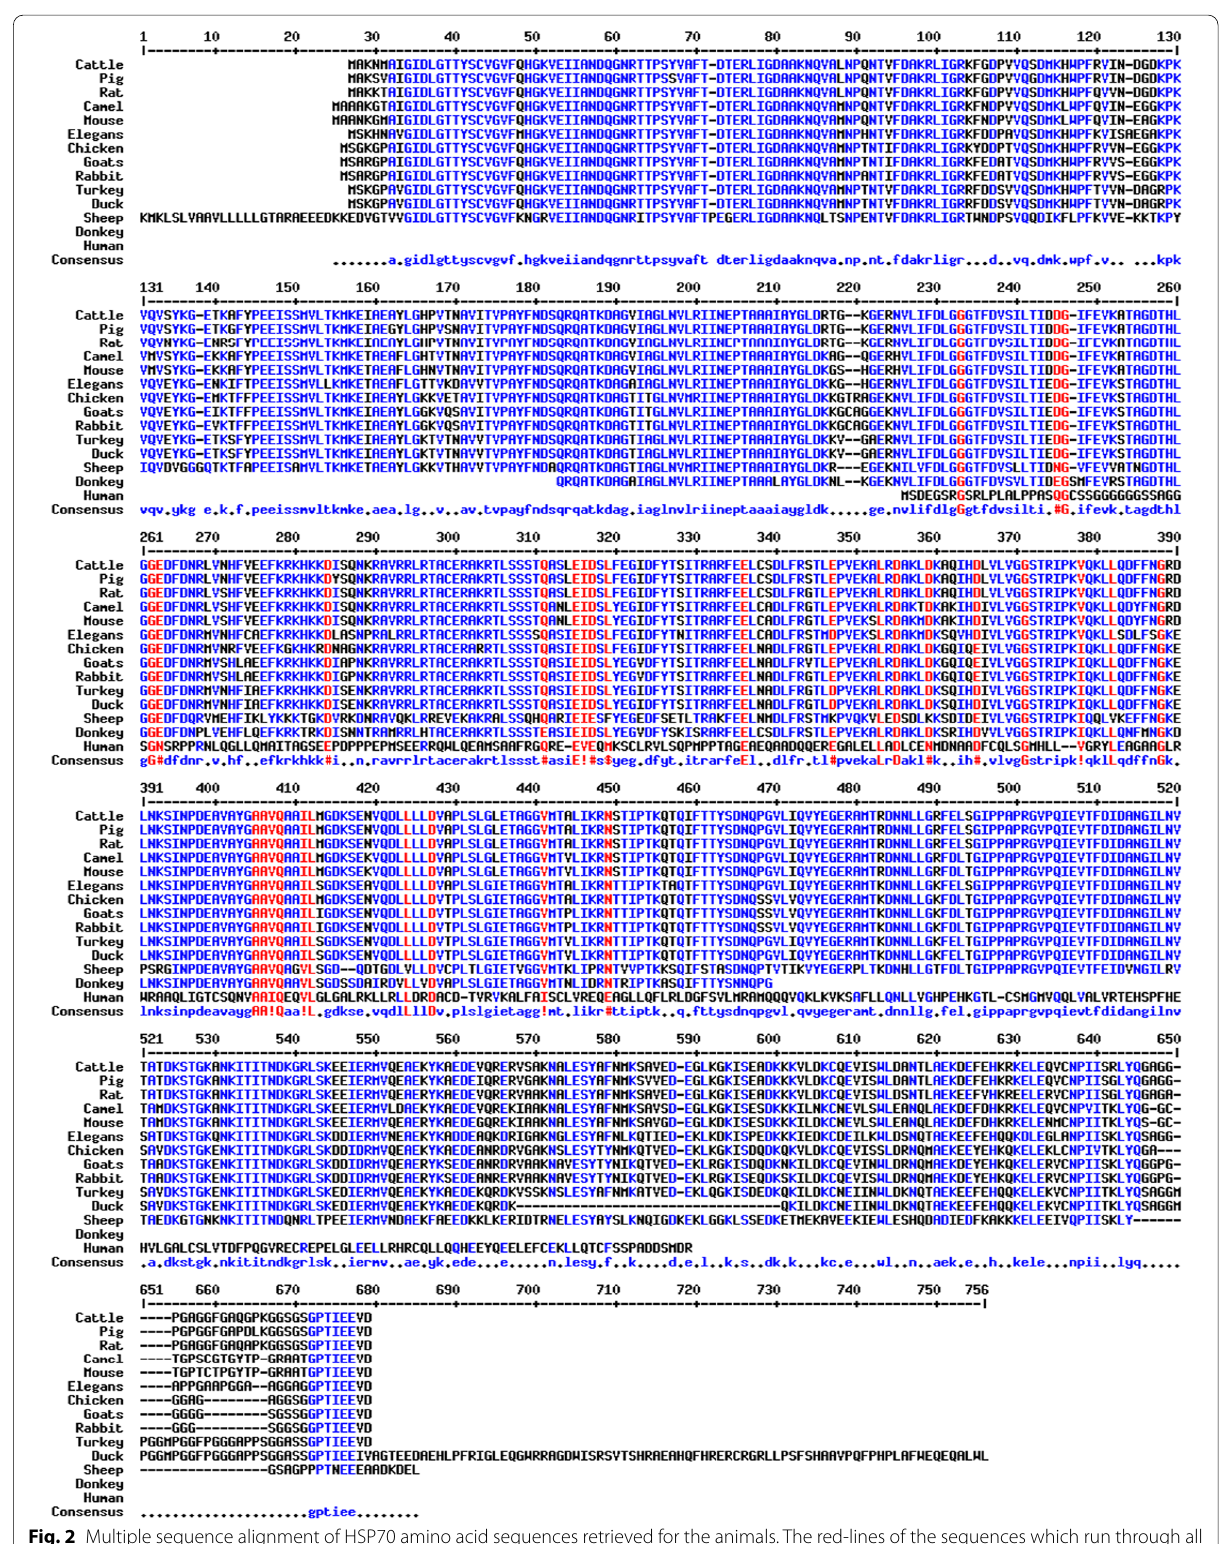
Fig. 2 Multiple sequence alignment of HSP70 amino acid sequences retrieved for the animals. The red-lines of the sequences which run through all the animals’ species are the conserved amino acid